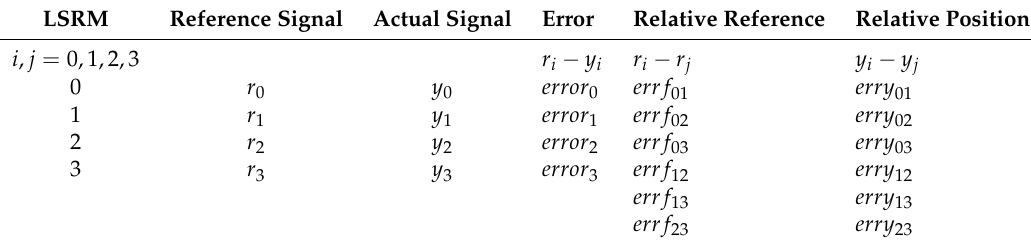
Table 3. Parameter